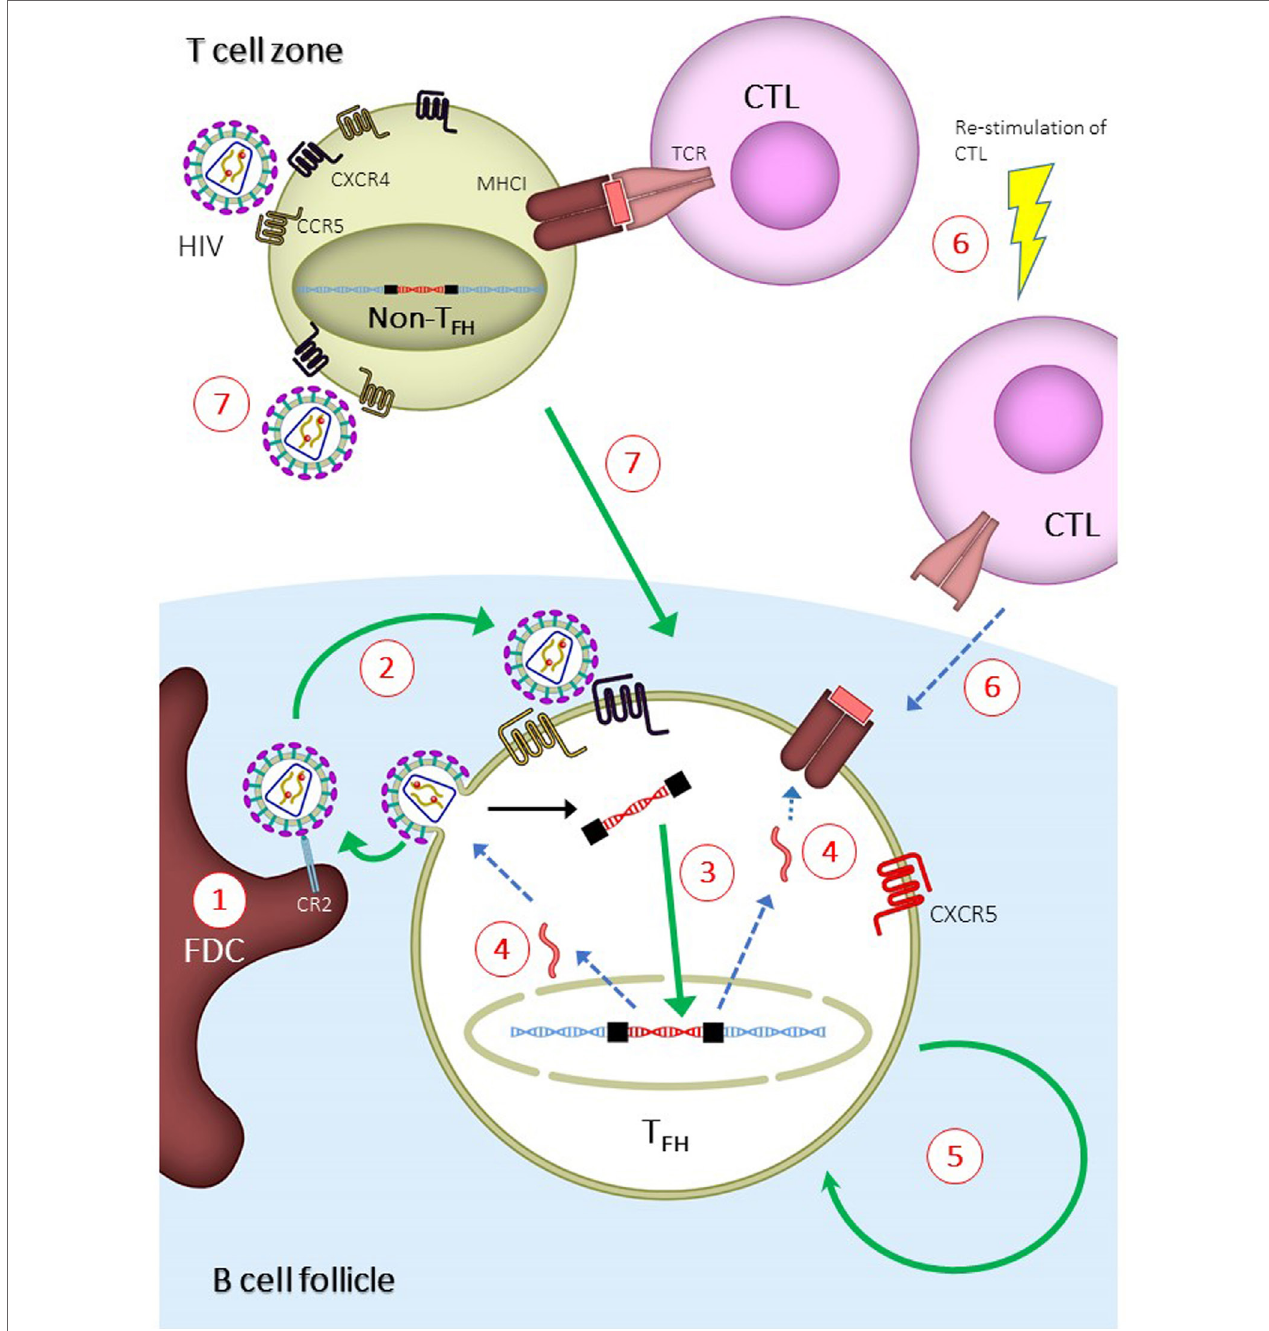
FigURe 2 | Mechanisms for the establishment of follicular T helper (T FH ) cells as major human immunodeficiency virus (HIV) reservoir and proposed strategies to eliminate T FH reservoir. Green or blue arrows indicate pathways that are enhanced or inhibited, respectively, during the establishment of T FH reservoir. (1) Virus- immune complexes deposition on follicular dendritic cells (FDCs) via complement receptor type 2 (CR2) binding. Anti-CR2 can be used to displace virus-immune complexes. (2) Infection of T FH due to suboptimal antiretroviral drug penetration, which can be overcome by development of drugs with higher potency. (3) Increased integration of viral DNA in T FH cells. This can be overcome by inducing host restricting factors, such as SAMHD1, or treatment intensification with integrase inhibitor. (4) Reduced expression of viral genes, which can be overcome by latency reversal agent. (5) Long half-life and homeostatic renewal of latently infected T FH cells. Long-term survival can be inhibited by targeting specific pathways, such as modulation with cytokines and auranofin. (6) Reduced infiltration of CD8 + T lymphocytes (CTLs) into B cell follicles. Potency and follicular infiltration of CTLs can be boosted to control T FH infection. (7) Infection of non-T FH and differentiation of infected non-T FH to T FH . This can be blocked by preventing the differentiation of T FH